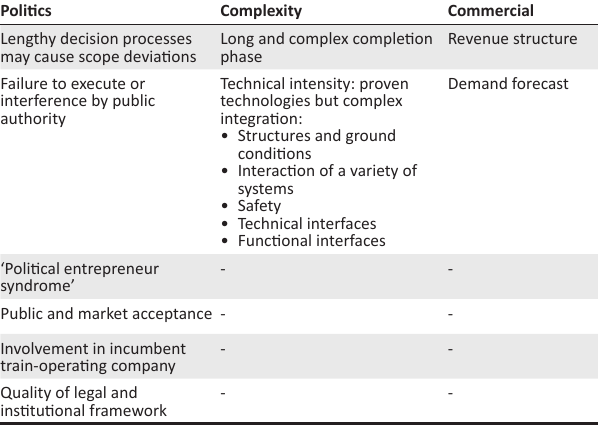
TABLE 1: Main causes of failures of rail public–private